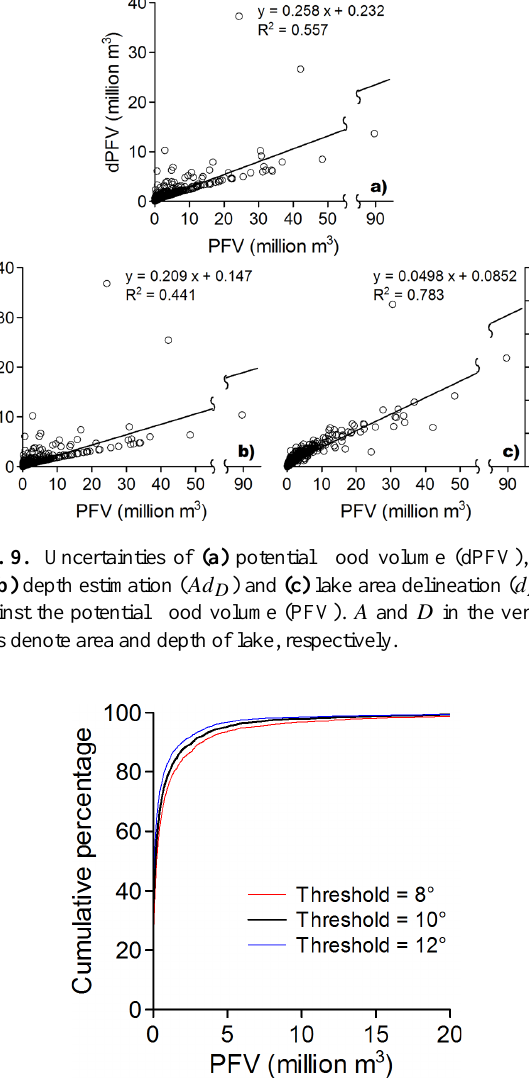
Fig. 10. Cumulative frequency distributions for the 2276 Himalayan glacial lakes against potential flood volume (PFV). PFVs in the dif- ferent threshold depression angles are depicted. Lakes having PFV greater than 20millionm 3 are not